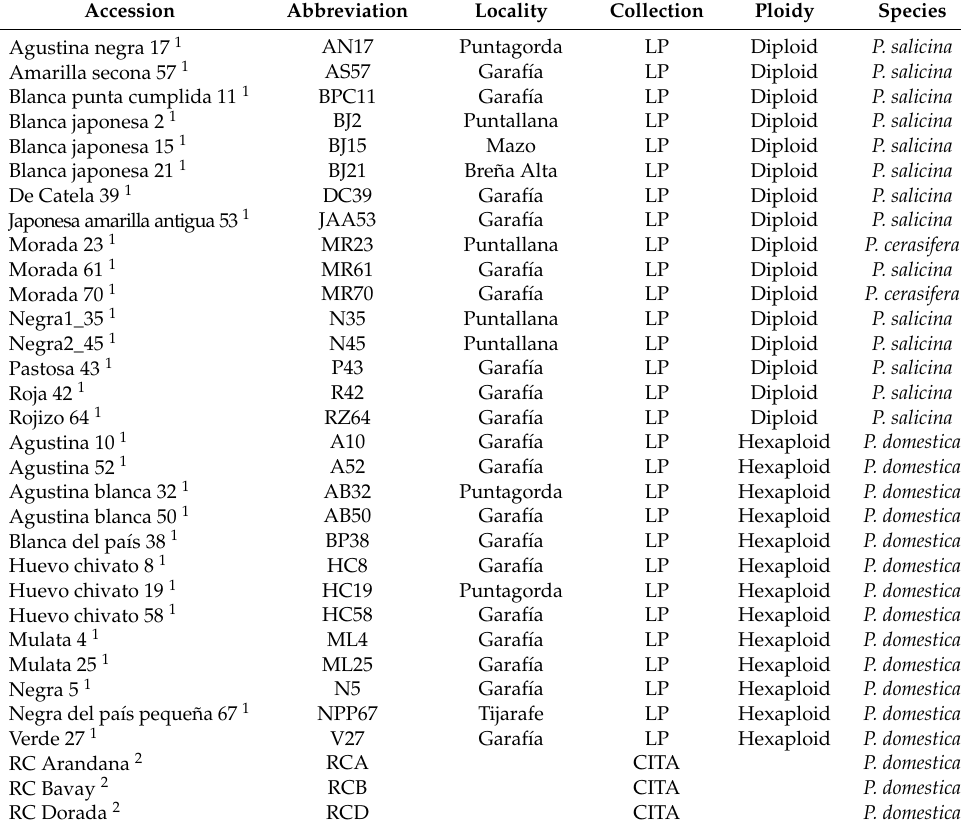
Table 2. List of 51 accessions used in this study from La Palma (LP) and CITA in Zaragoza (CITA) collections, with accession name, abbreviation name, locality of prospection, collection of origin, ploidy level analyzed using flow cytometry and assigned